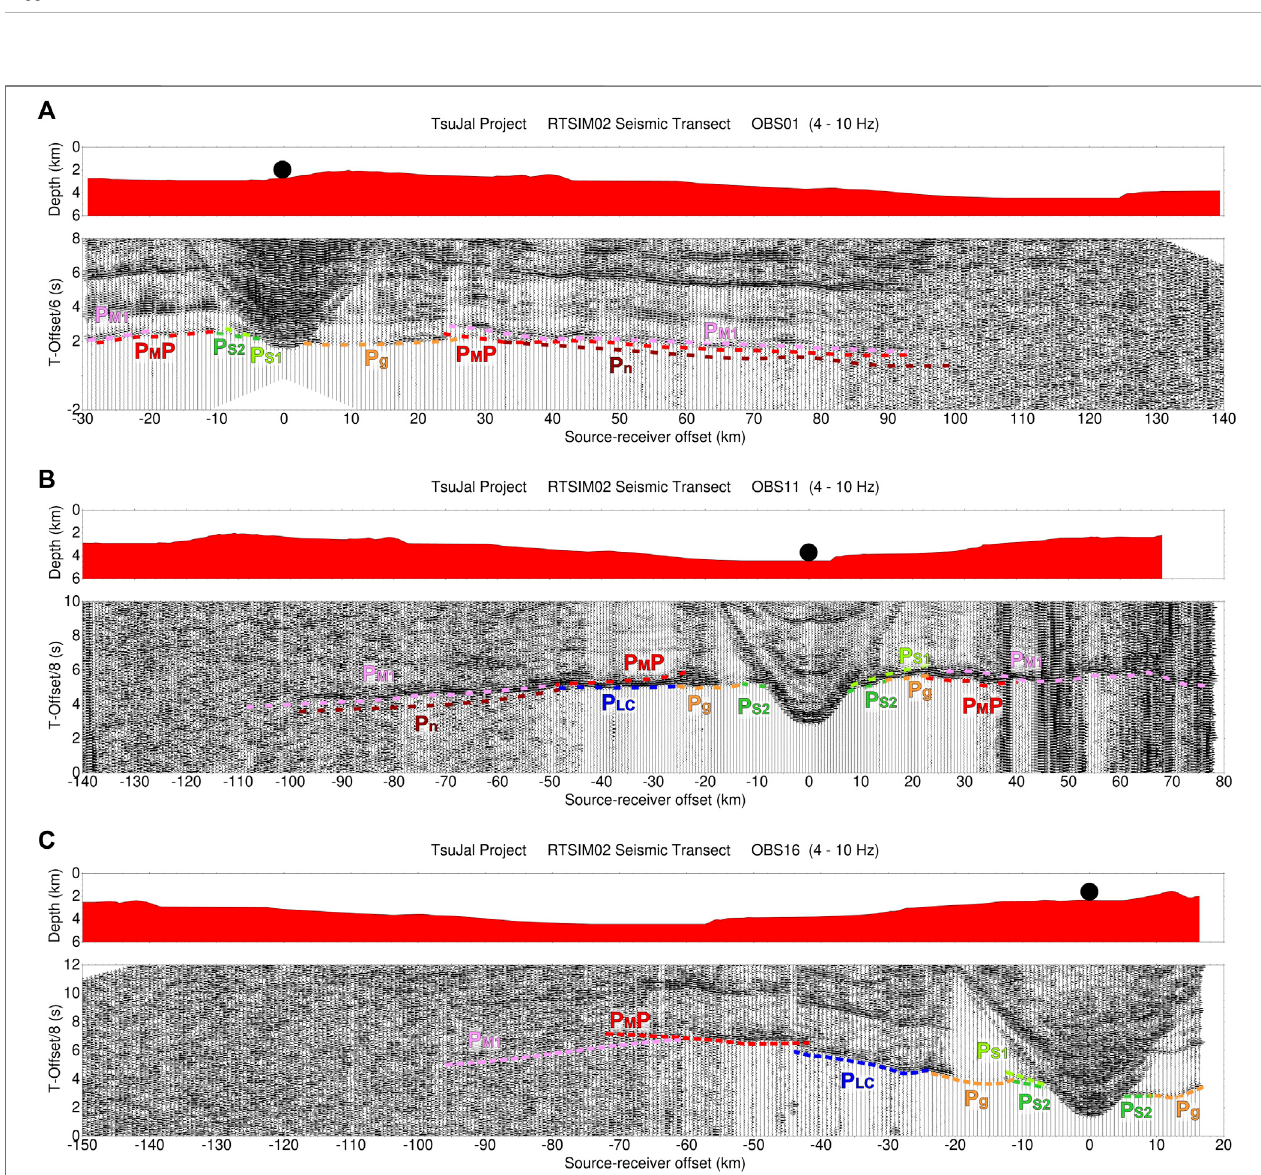
FIGURE 3 | Record sections of the marine seismic stations recording the RTSIM02 seismic transect. All of them have the bathymetry along with the RTSIM02 seismic pro fi le in the upper panel. The lower panel shows the vertical component of the corresponding station with a reduced velocity of 6 km/s (OBS01) and 8 km/s (OBS11 and OBS16), 4 – 10 Hz band-pass fi lter applied, trace-normalized amplitudes, and interpreted re fl ected and refracted P-wave horizons indicated by different color dashed lines. (A) OBS01; (B) OBS11; (C) OBS16.